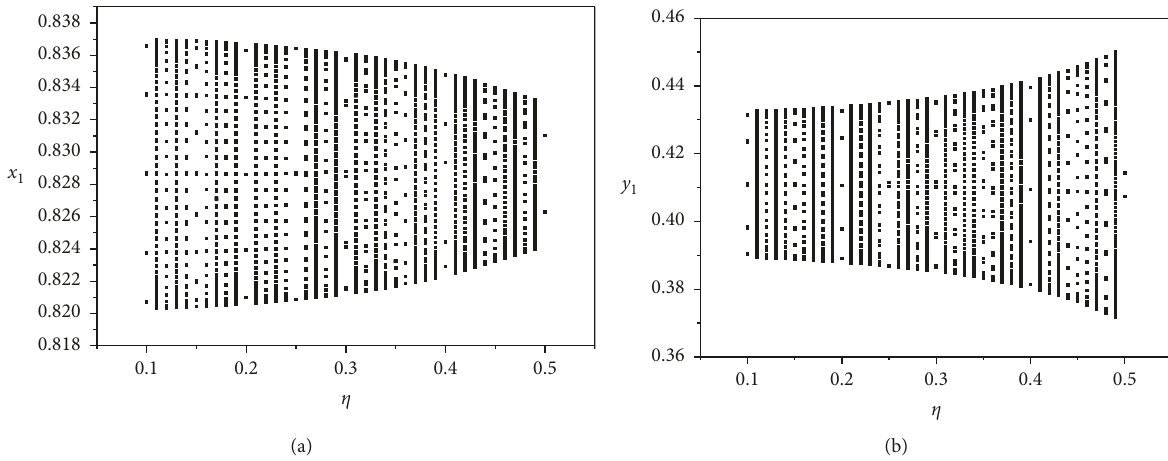
Figure 10: Dynamic bifurcation diagram: (a) x